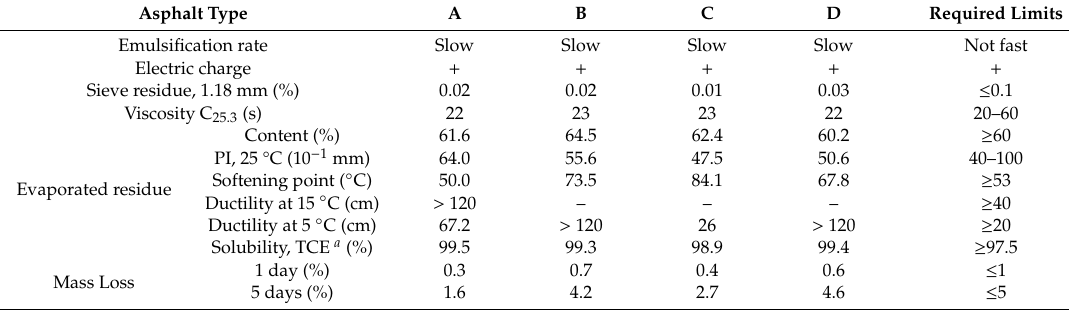
Figure 1. ( a ) Styrene–ethylene–butylene–styrene (SEBS) modifier; ( b ) styrene–butadiene rubber (SBR) latex. Table 1. Performance of emulsified asphalt. PI—penetration index.